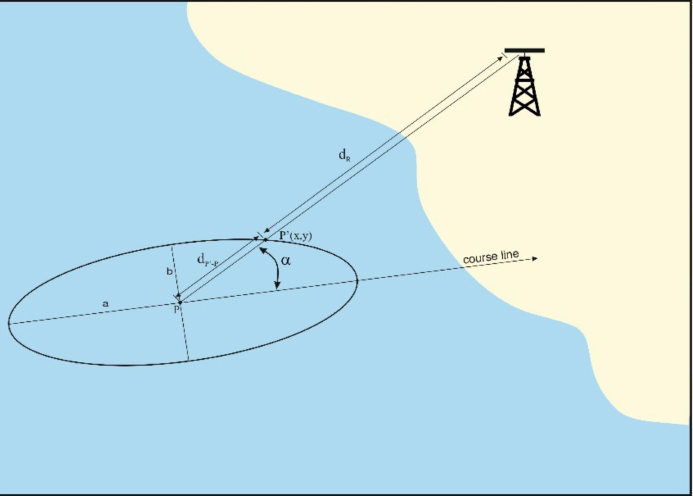
Figure 3. Measurement structure while determining the radar distances d R measured to the bow section of the